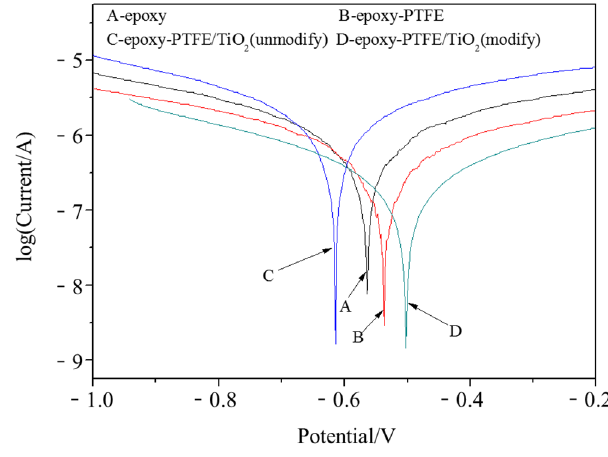
Figure 9. Potentiodynamic polarization curves of different coatings. Table 1. Potentiodynamic polarization parameters of different coatings.